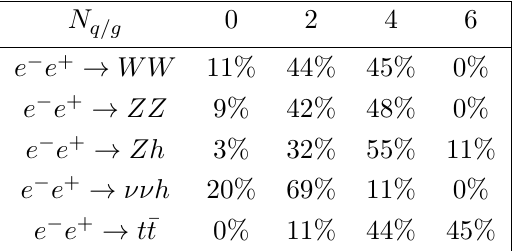
= 0, 2, 4 and 6 represents the number of q=g